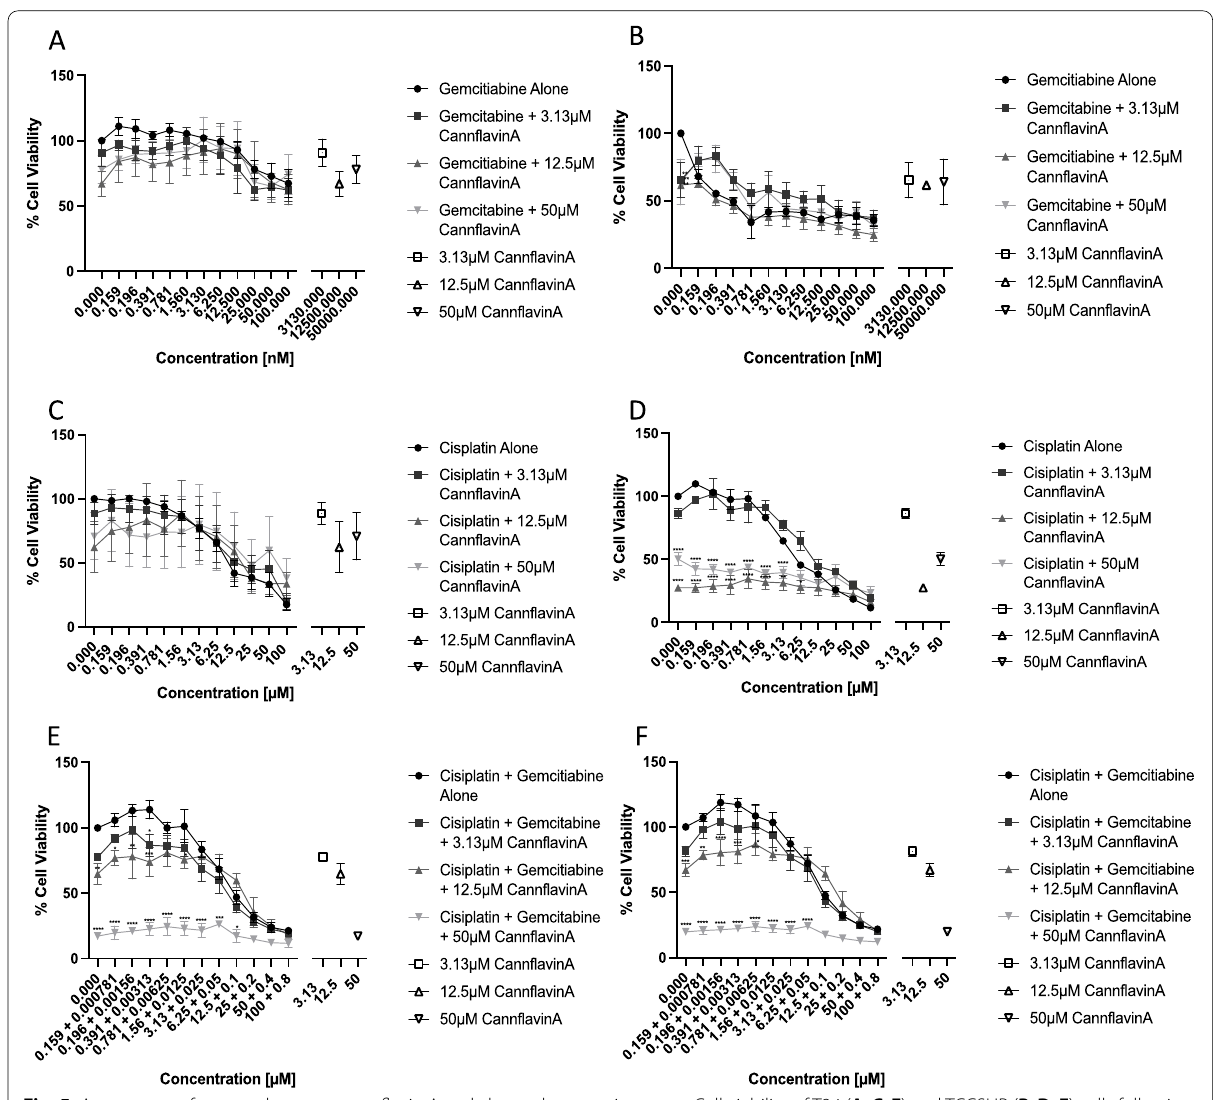
Fig. 5 Assessment of synergy between cannflavin A and chemotherapeutic agents. Cell viability of T24 ( A , C , E ) and TCCSUP ( B , D , F ) cells following treatment with gemcitabine ( A and B ) cisplatin ( C and D ) or cisplatin/gemcitabine ( E and F ) combined with 3.13, 12.5, or 50 μM cannflavin A. The statistics indicate the significance of the addition of the various concentrations of cannflavin A compared to treatment with chemotherapeutic agents alone. In each graph, the effect of cannflavin A at 3.13, 12.5, or 50 μM cannflavin A is indicated by open data points (on the right of the graph). Results represent the means SEM of 3 experiments. * p <0.05, ** p <0.01, *** p <0.001, **** p ±